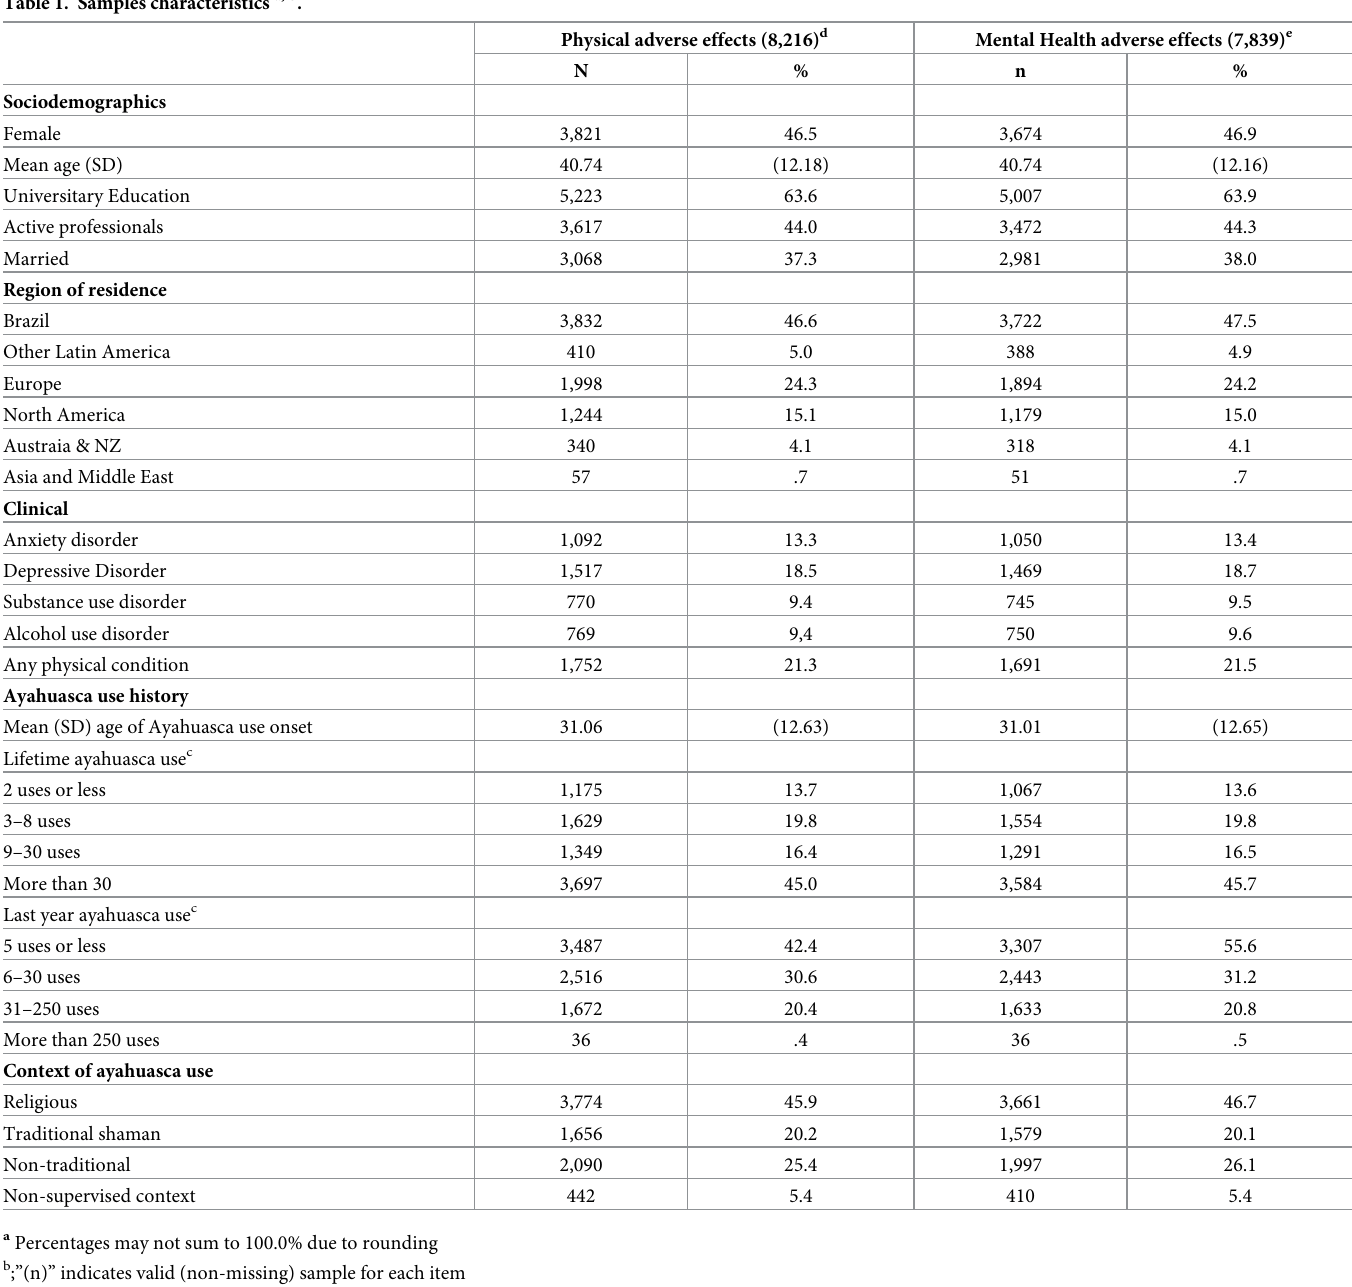
Table 1. Samples characteristics a, b